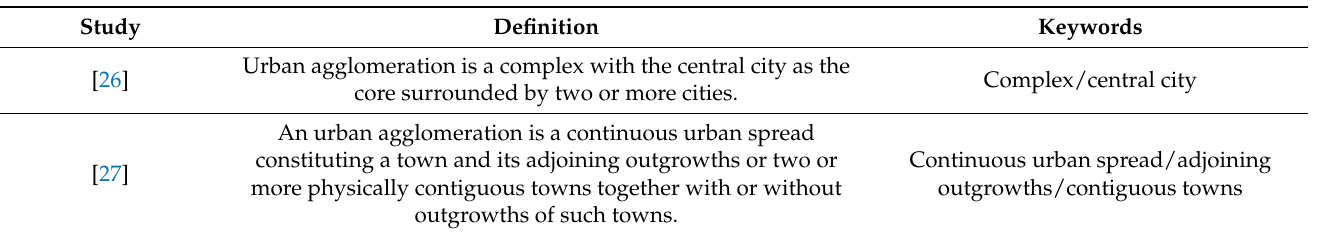
Table 1. Definitions of urban